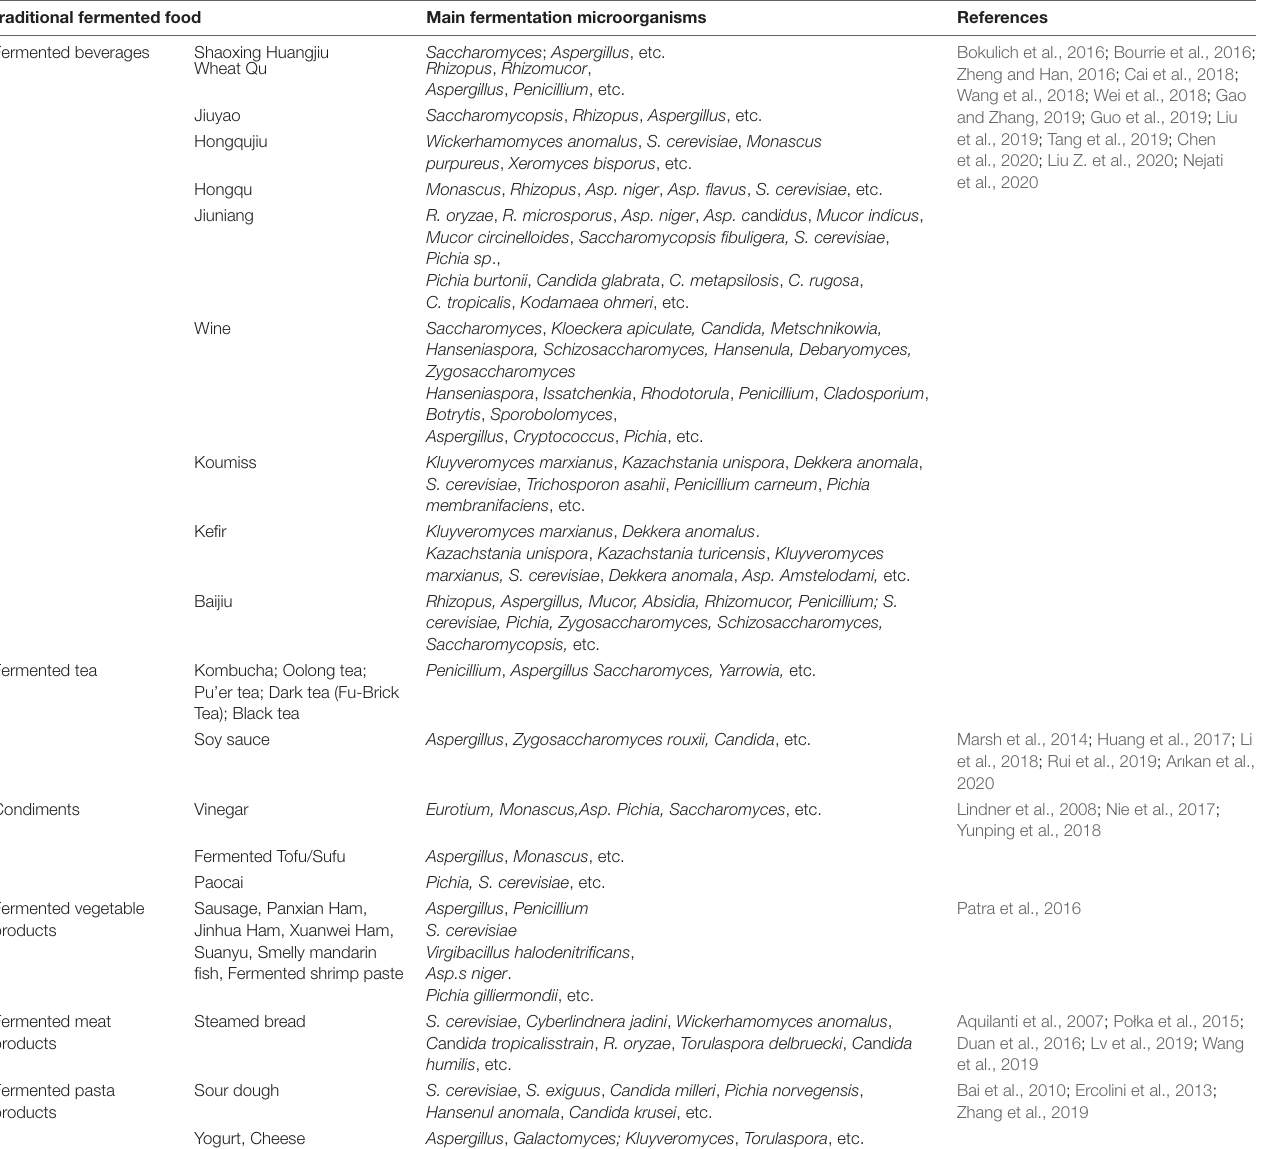
TABLE 2 | Research advances in studying microbial community composition and function of traditional fermented